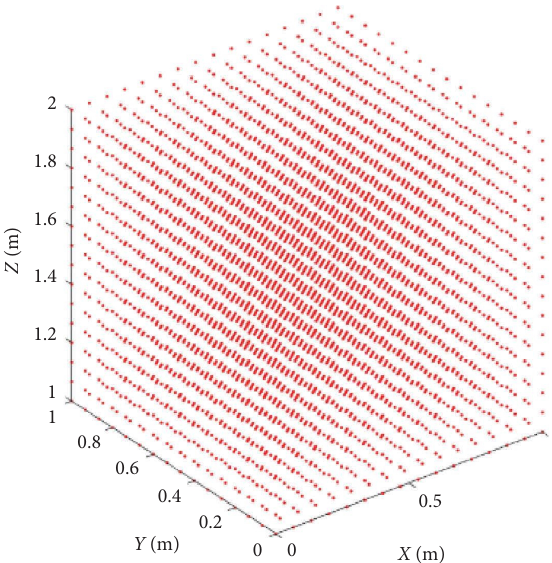
Figure 4: Gamma (3) DSD.